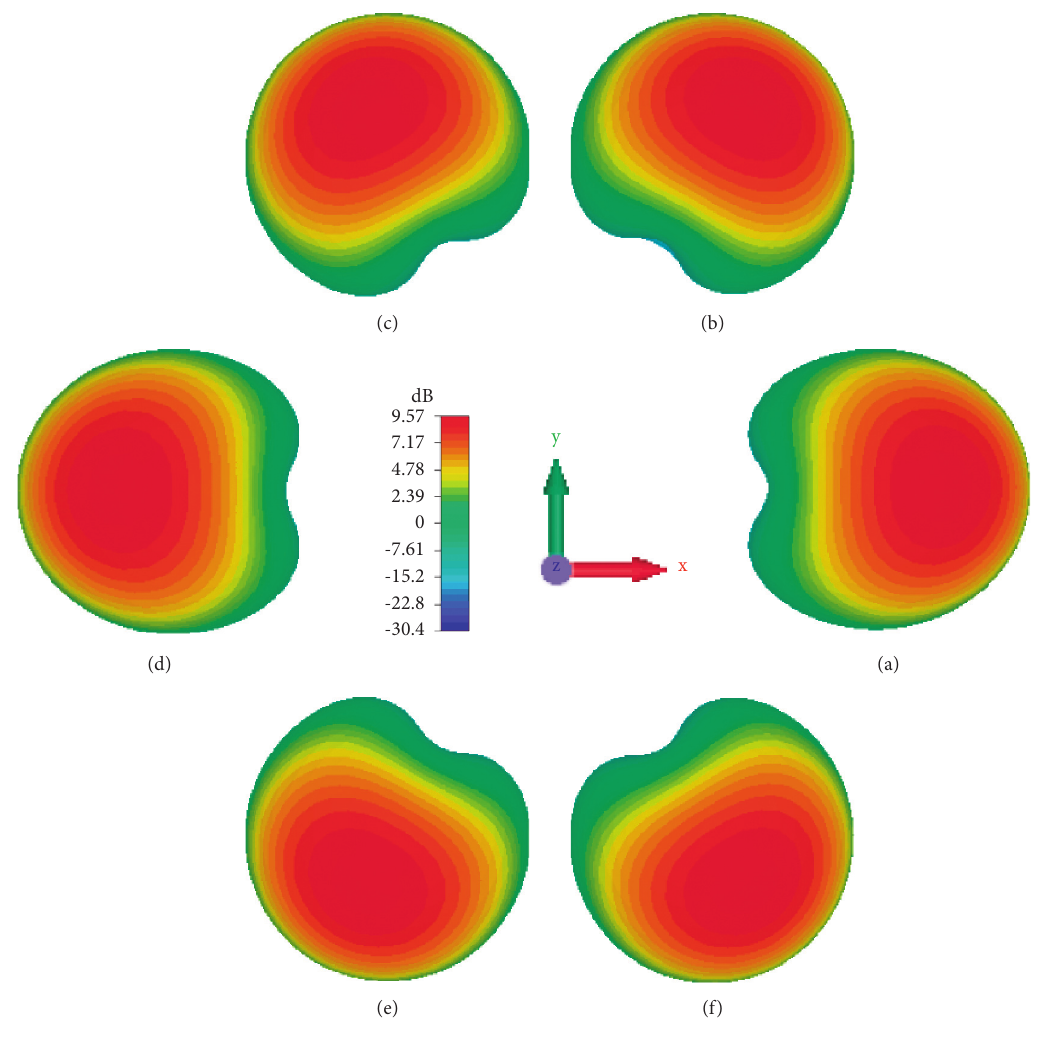
Figure 13: Simulated 3D radiation patterns at 5.82 GHz. Table 4: Comparison between the proposed reconfigurable antenna and several other reconfigurable